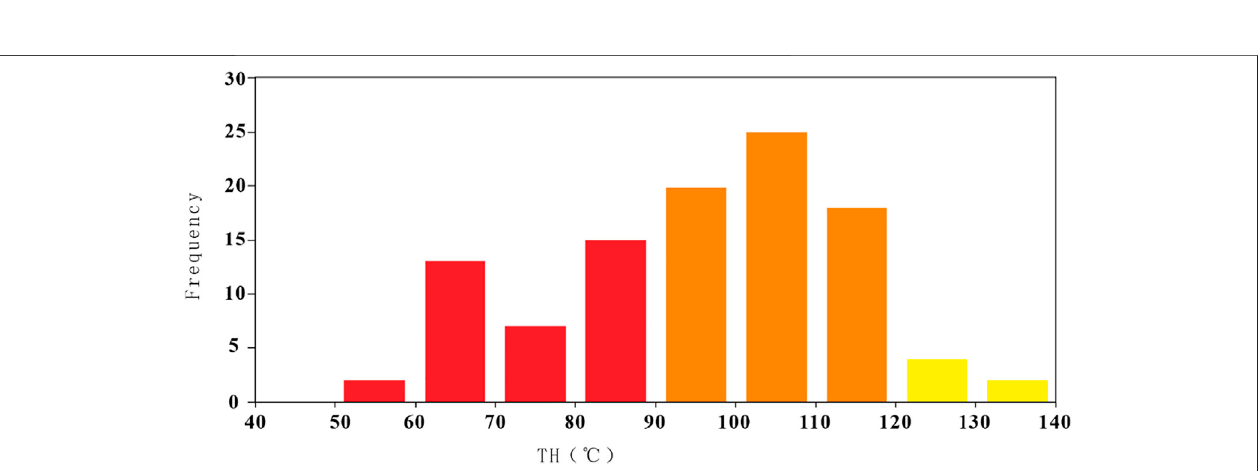
FIGURE 13 | Characteristics of fl uid inclusions in Ordovician carbonate reservoirs in the Repu block.